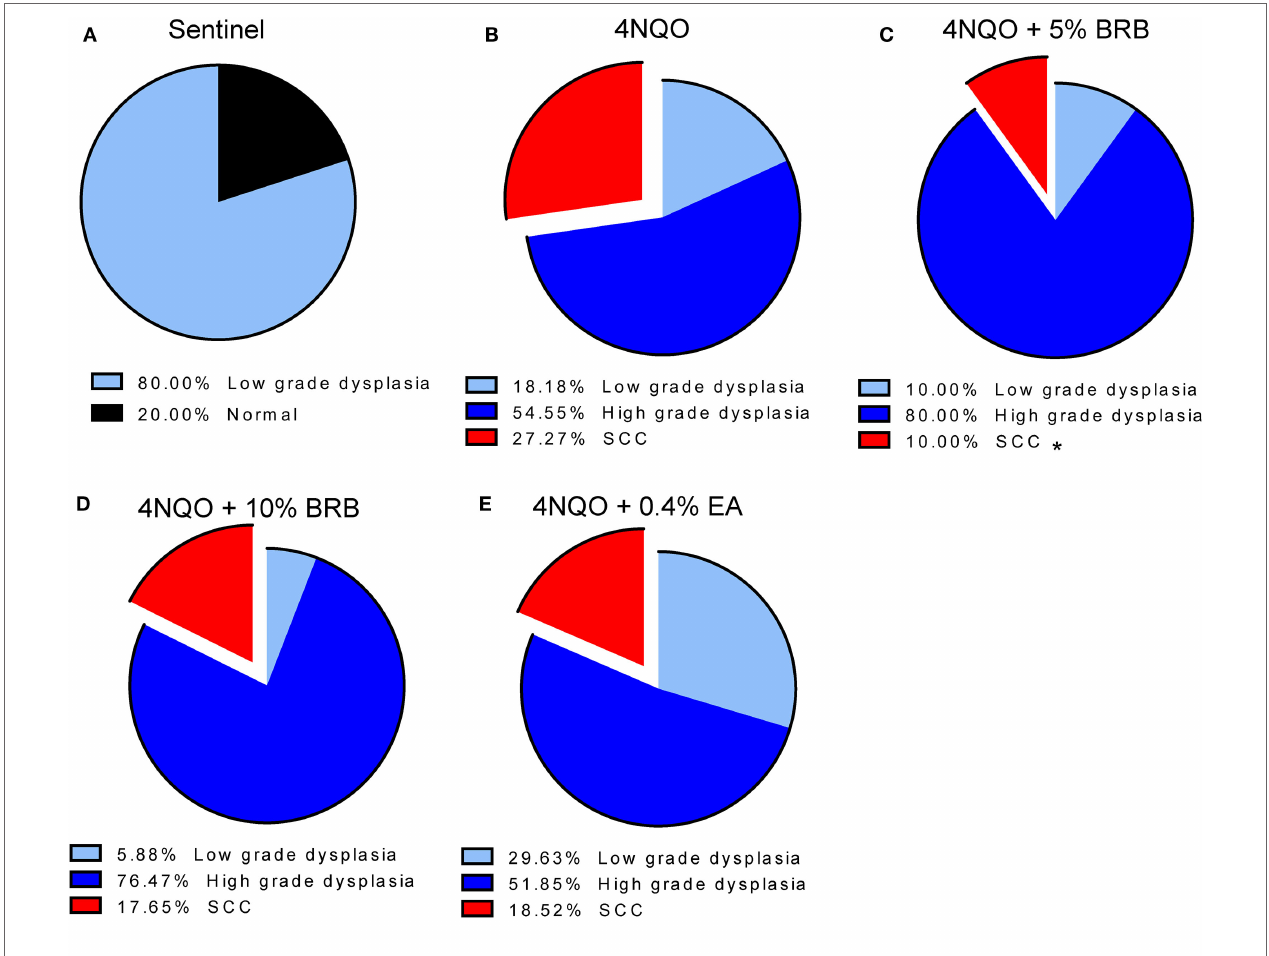
FigUre 3 | (a–e) Histopathological analysis of tongue tissues from untreated and treated carcinogen-induced rats. Distribution of the histopathological grades (normal, low-grade dysplasia, high-grade dysplasia, and SCC) in tongue epithelia of (a) sentinel rats, (B) 4-nitroquinoline 1-oxide (4NQO)-induced rats fed control diet, (c) 4NQO-induced rats fed diet supplemented with 5% black raspberry (BRB), (D) 4NQO-induced rats fed diet supplemented with 10% BRB, and (e) 4NQO-induced rats fed diet supplemented with 0.4% ellagic acid (EA). Note the significantly reduced percentage of SCCs in 4NQO exposed rats treated with 5% BRB. * p -value < 0.05 for SCC incidence comparison between 4NQO-only exposed rats and 4NQO + 5% BRB rats, using independent Student’s t